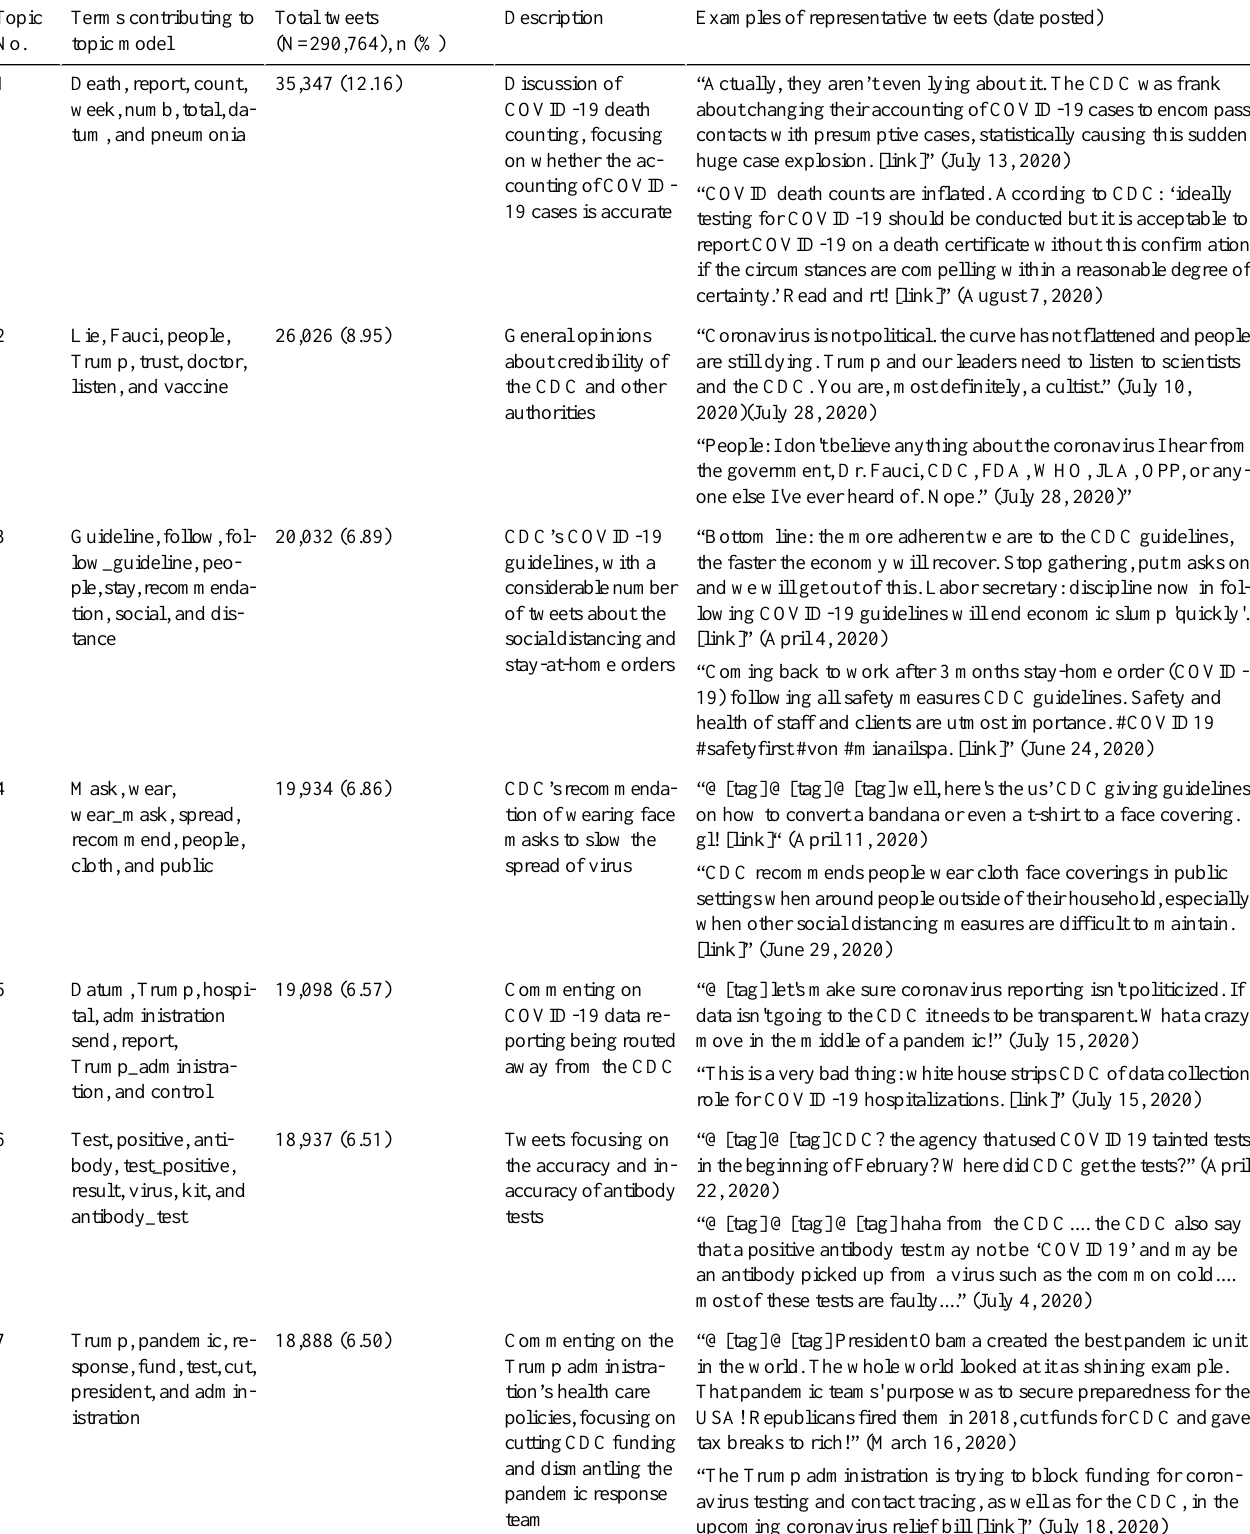
Examples of representative tweets (date posted)DescriptionTotal tweets